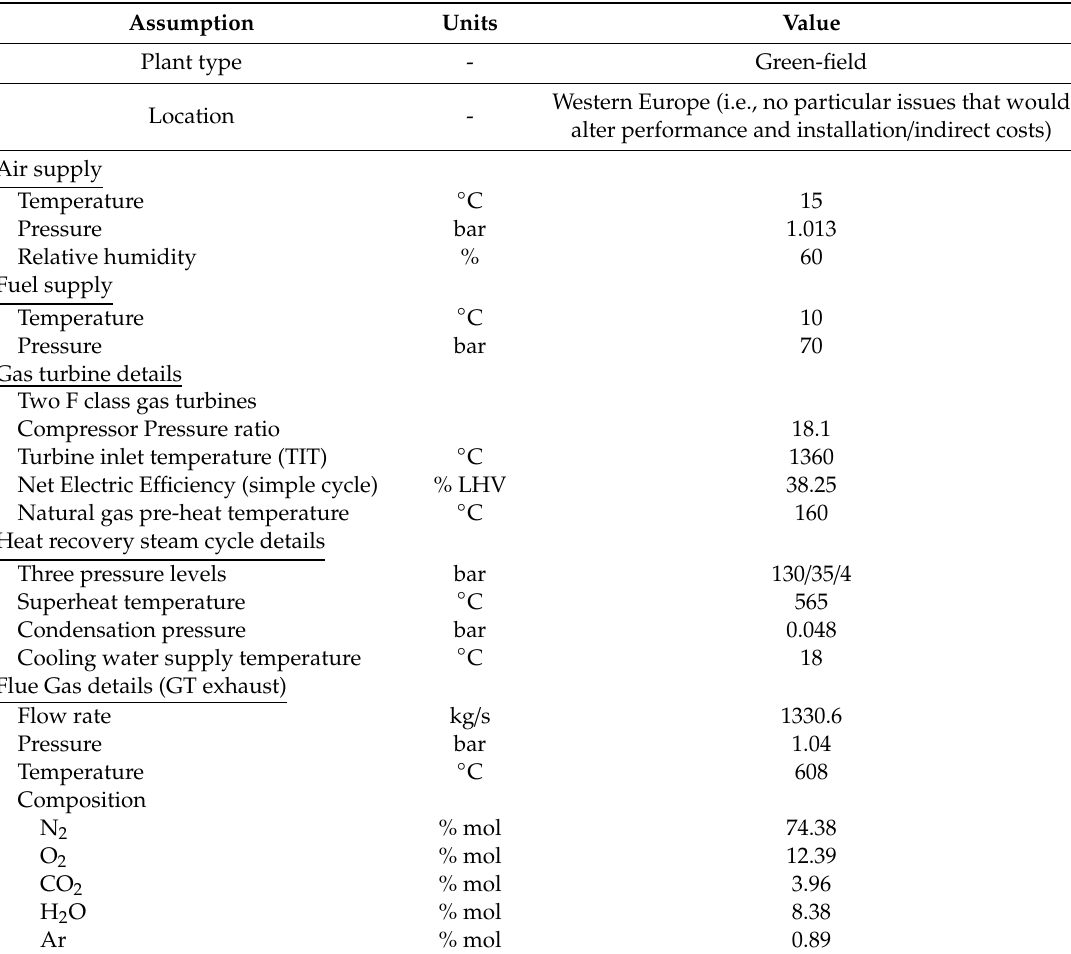
Table 1. Key Assumptions for the performance evaluation of the natural gas combined cycle (NGCC) baseline.